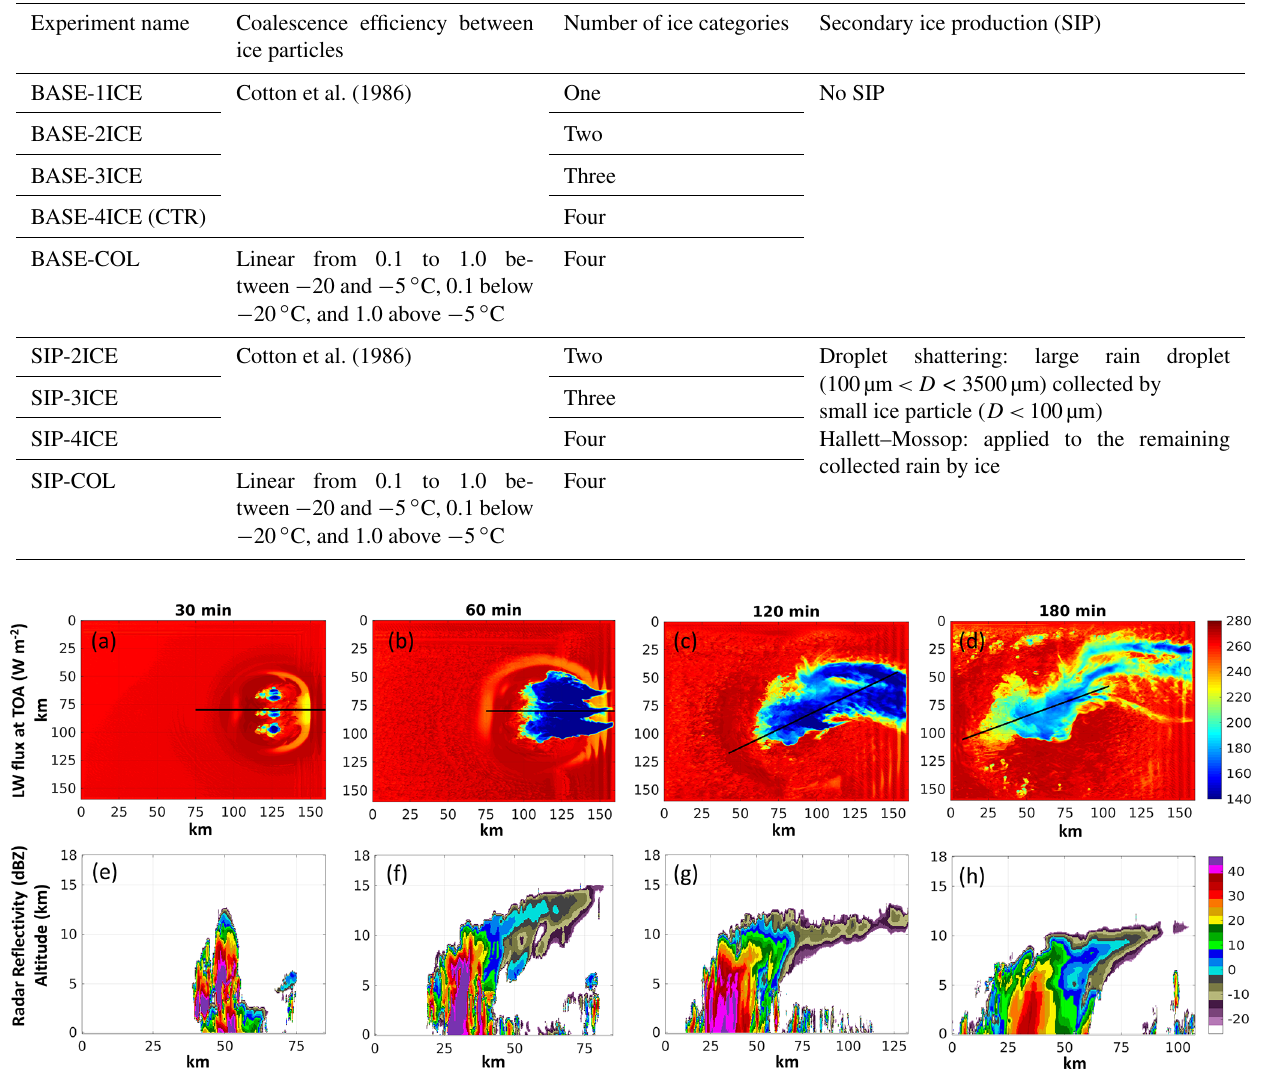
Figure 3. Simulation with a single ice category in the P3 bulk microphysics scheme for (a–d) upward longwave radiative flux at the top of atmosphere at four different times (30, 60, 120, and 180min after the model initiation), and (e–h) the corresponding radar reflectivity of the cross section marked by the black line in panels (a) – (d)